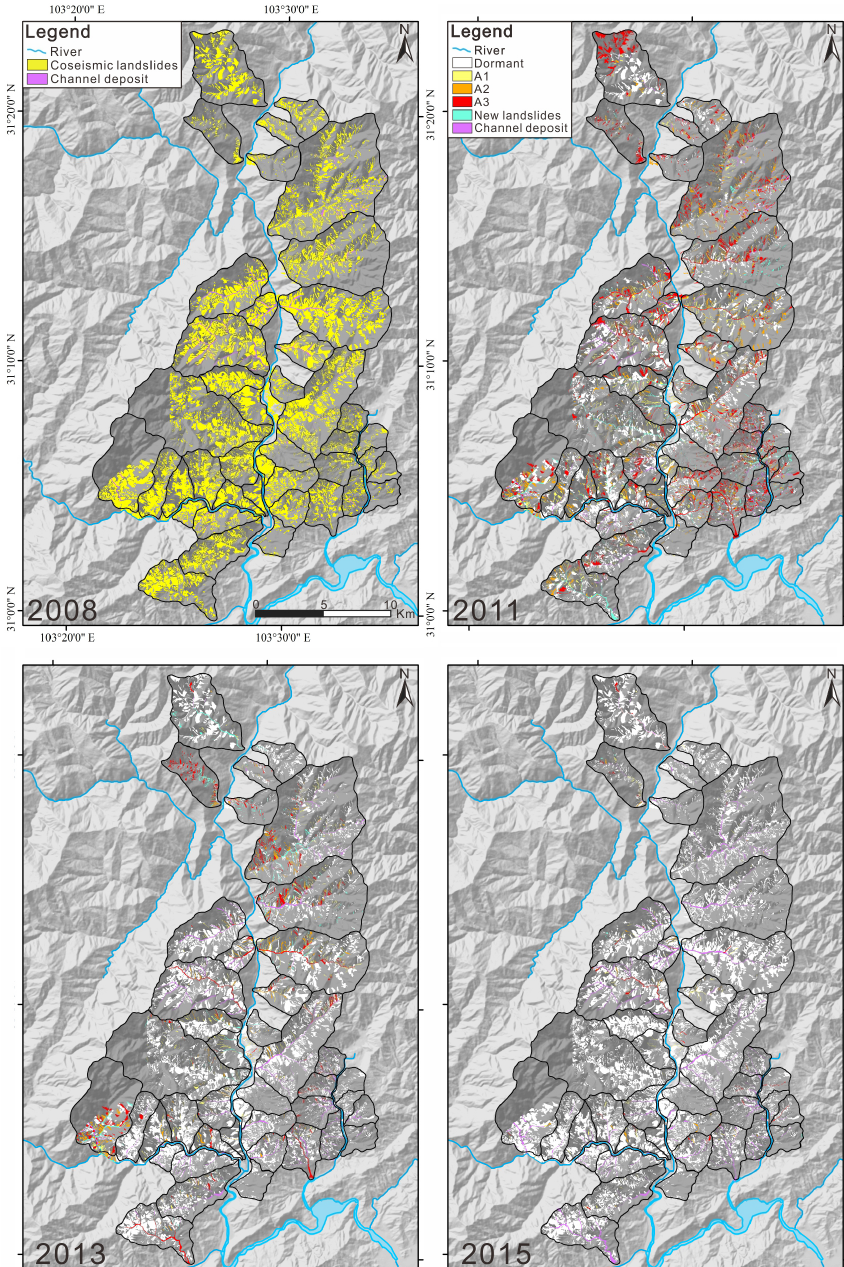
Figure 3. Coseismic landslides, post-seismic remobilisation of coseismic landslide deposits and post-seismic landslides (new landslides) identified from remote-sensing images recorded in 2008, 2011, 2013, 2015, 2017 and 2018. For the remobilisations, the levels of activity are also